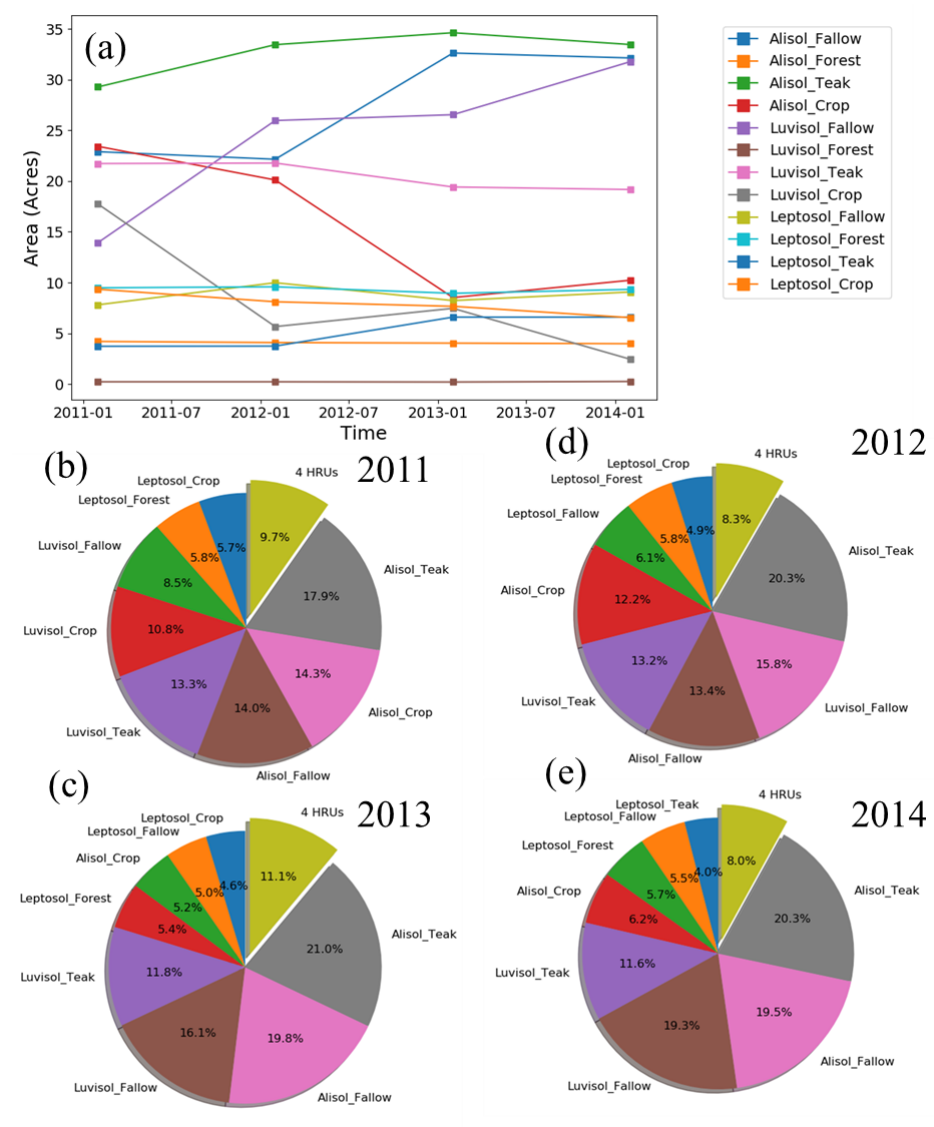
Figure 7. Discretization of a catchment in Laos (Boithias et al., 2021) according to the HRU definition of “unique land use in unique soil”. The catchment consists of three soil types and four land use types. The soil types are Alisol, Luvisol, and Leptosol, while the land use types are fallow, forest, teak, and crop. The combination of soil types and land use types results in 12 distinct HRUs. Panel (a) shows annual variation in these 12 land use types, while (b)–(e) show the percentage area of HRUs in the catchment in 2011, 2012, 2013, and 2014,